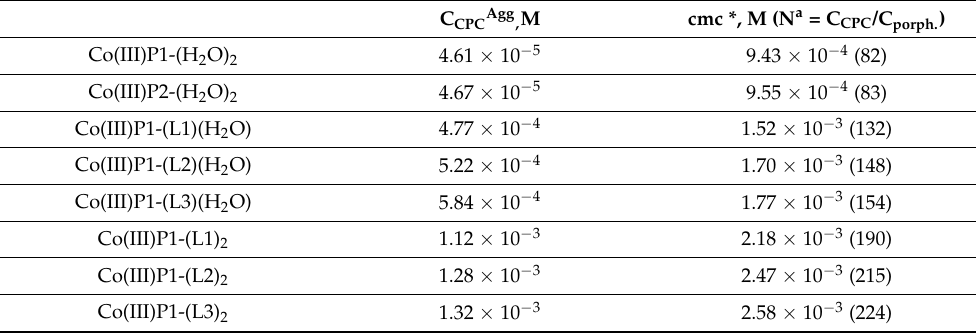
Table 3. CPC concentrations at which premicellar aggregates and micellated porphyrinates are formed (C porph. = 1.15 × 10 − 5 M).